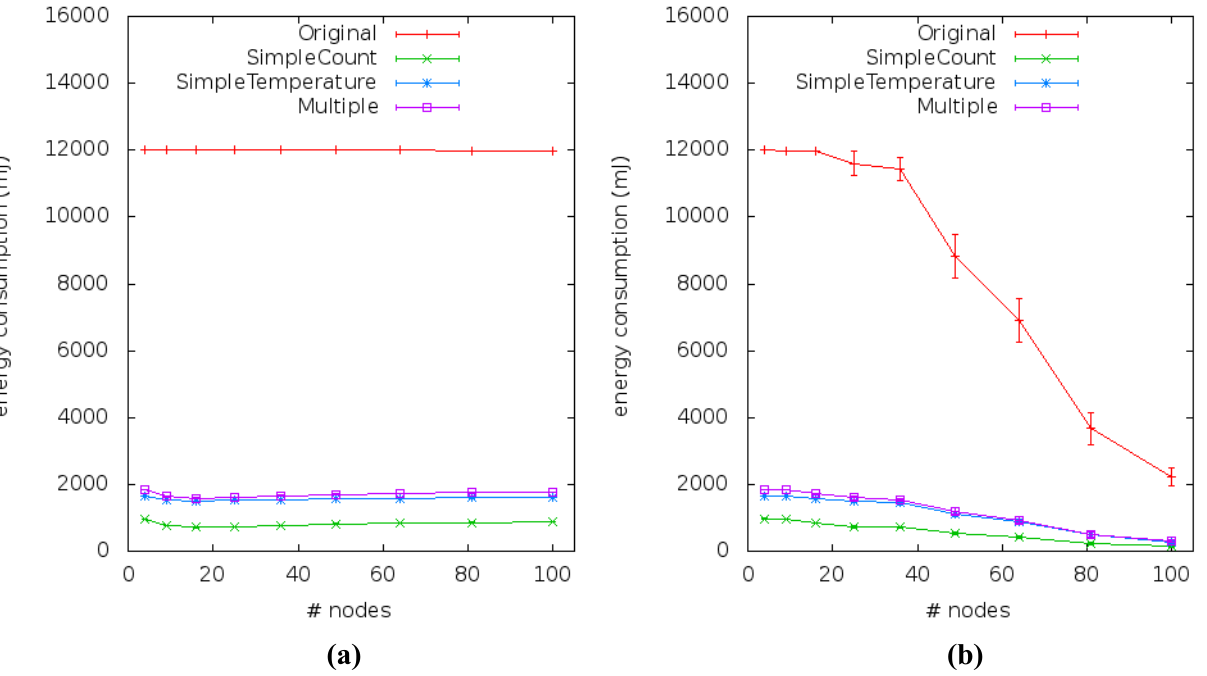
Figure 14. Average energy of the radio consumed by messages sent to the sink: